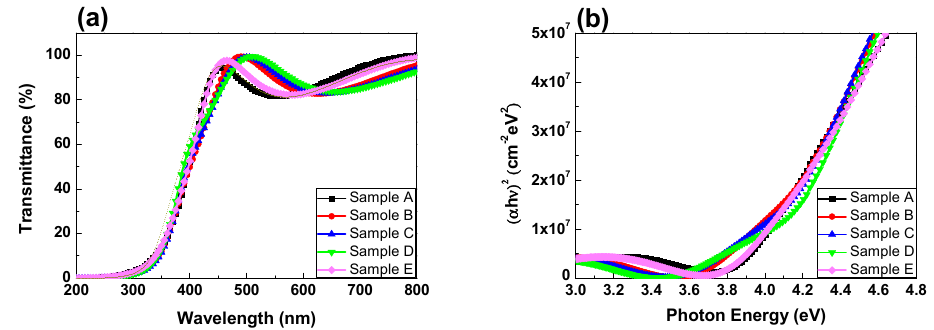
Figure 3. ( a ) Transmittance spectrum measured from Samples A, B, C, D, and E. ( b ) Absorption coefficient versus photon energy for these five samples.